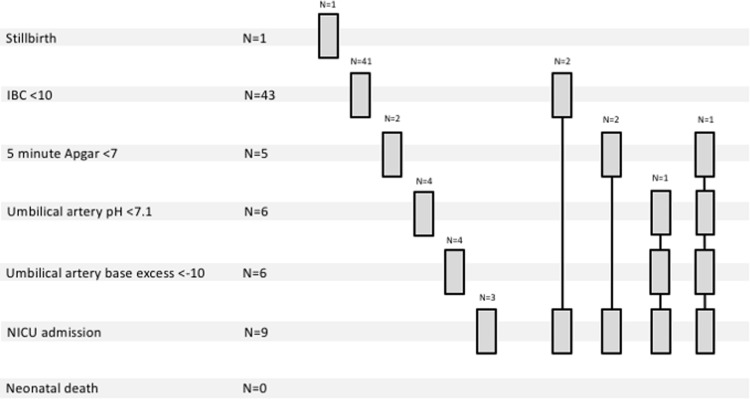
Breakdown of adverse pregnancy outcomes within the FEMINA2 study cohort.Adverse pregnancy outcome was diagnosed on the basis of the occurrence of one or more classifier of adverse outcome: stillbirth, individualised birth weight centile (IBC)<10, five minute Apgar score<7, umbilical arterial pH<7.1 or base excess<-10, admission to neonatal intensive care unit (excluding for fetal abnormality, jaundice or sepsis) or neonatal death before discharge.